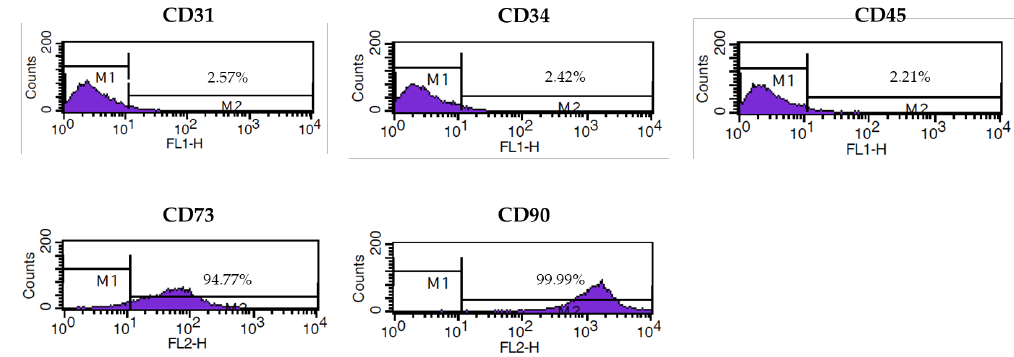
Figure 1. Characterization of human adipose-derived stem cells (ASCs) The surface markers were analyzed by flow cytometry in ASCs with positive expression of CD73 and CD90 but negative for CD31, CD34, and